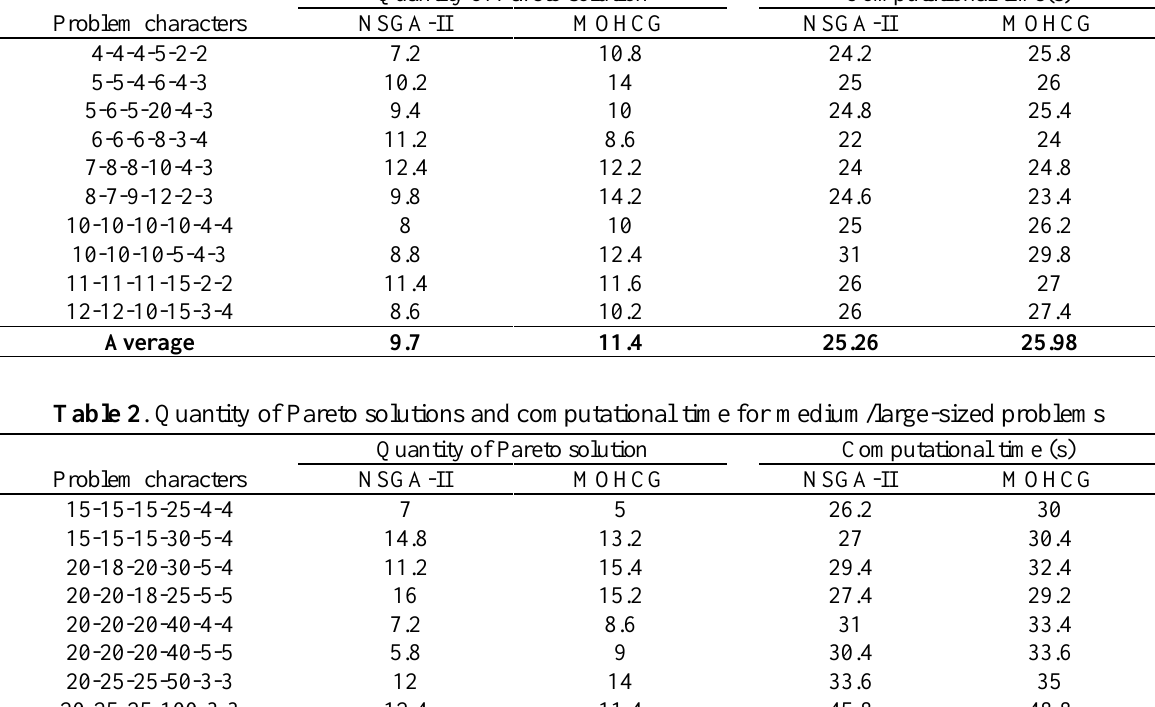
Table 1 . Quantity of Pareto solutions and computational time for small-sized problems Quantity of Pareto solution Computational time(s) Problem characters